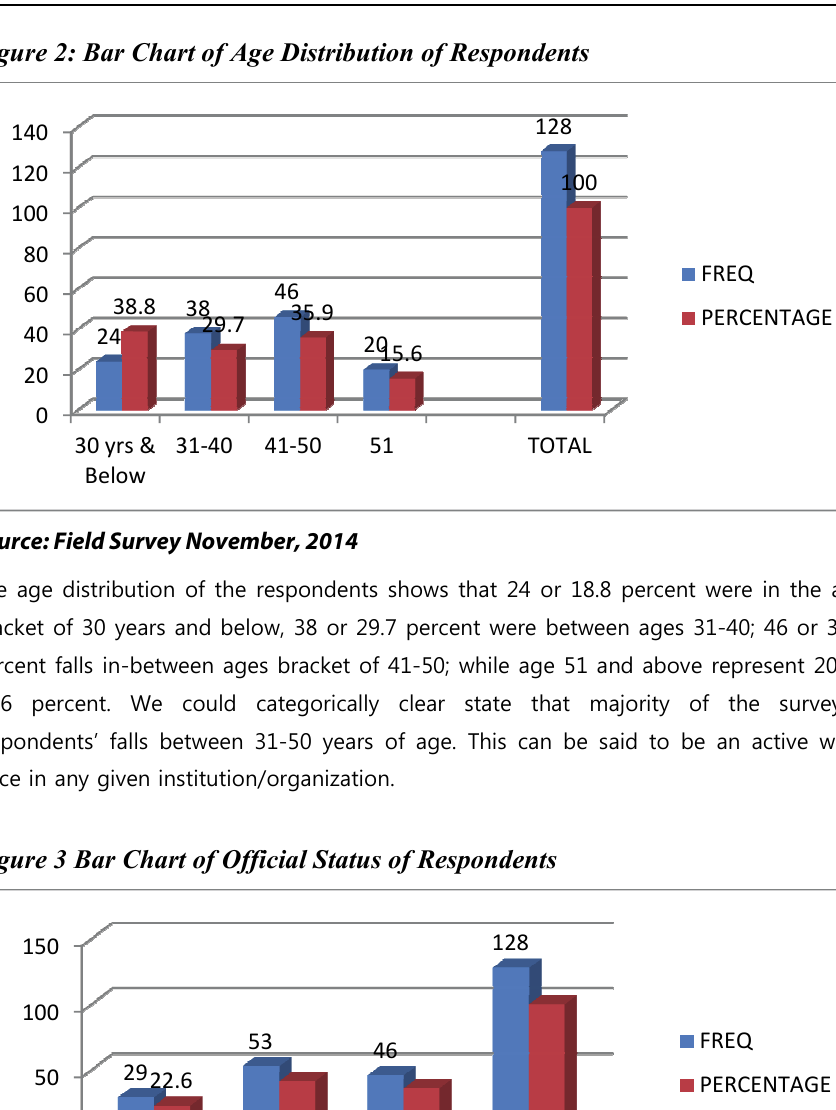
Figure 2: Bar Chart of Age Distribution of Respondents